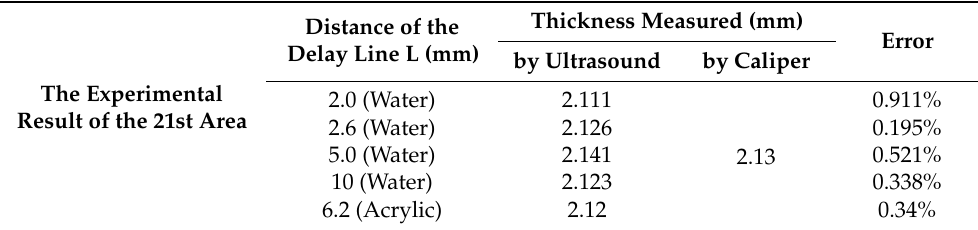
Table 4. Coating thickness measurements by caliper and ultrasound at 21st area.